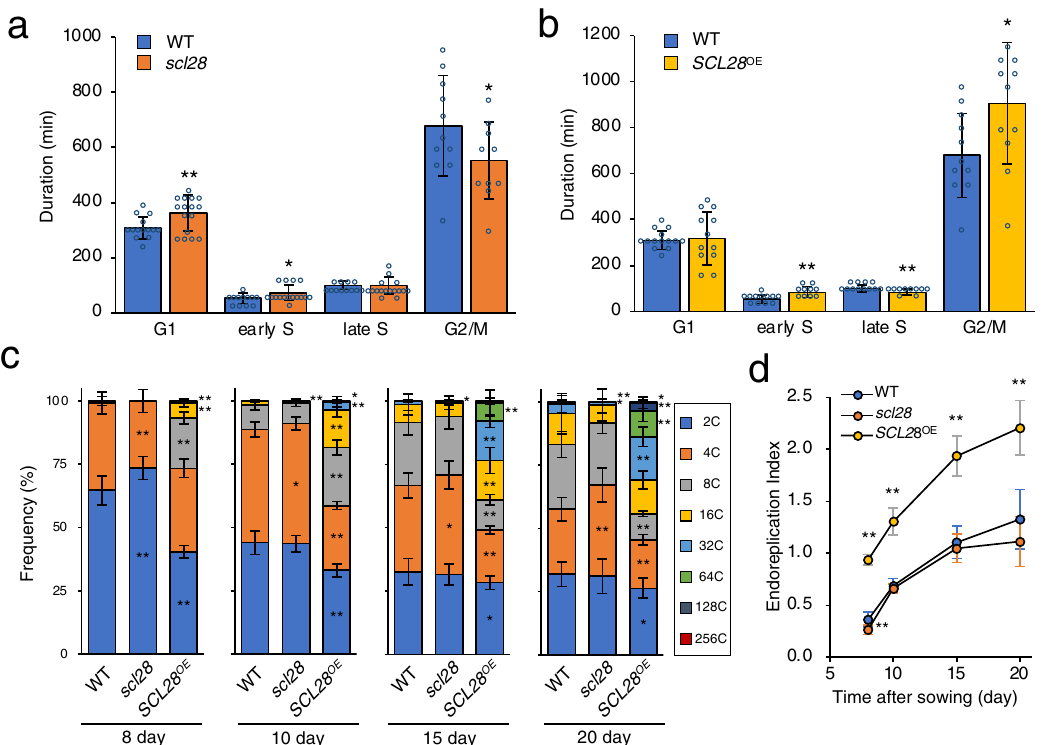
Fig. 3 SCL28 inhibits G2 progression and induces endoreplication. a G2 duration is shortened in scl28 . Epidermal cells in root meristems of WT, scl28 , and SCL28 OE plants carrying the PCNA-GFP marker were analyzed by live-cell imaging for measuring length of G1, early S, late S, and G2/M phases in the cell cycle. Data are shown as averages (±SD). Numbers of biological replicates for calculating length of G1, early S, late S, and G2/M, respectively, are 14, 12, 12 and 11 for WT, and 16, 16, 16 and 10 for scl28 . Statistical signi fi cance compared with WT was determined using one-sided Student ’ s t test. * P < 0.05, ** P < 0.01. b Prolonged G2 duration in SCL28 OE plants. Cell cycle analysis in the root meristem was performed as in ( a ). Data are shown as averages (±SD). Numbers of biological replicates for calculating length of G1, early S, late S, and G2/M, respectively, are 14, 12, 12 and 11 for WT, and 12, 10, 10, and 12 for SCL28 OE . Statistical signi fi cance was determined and shown as in ( a ). c Ploidy analysis of scl28 and SCL28 OE plants. First leaf pairs of WT, scl28 , and SCL28 OE plants were subjected to fl ow cytometric analysis to determine ploidy distribution during leaf development. Data are shown as averages from ten biological replicates (±SD). Statistical signi fi cance compared with WT was determined using two-sided Student ’ s t test. * P < 0.05, ** P < 0.01. d Time- course change in cellular ploidy levels during leaf development. Data presented in ( c ) were used for calculating endoreplication index, which represents mean number of endoreplication cycles per leaf cells. Data are shown as averages from ten biological replicates (±SD). Statistical signi fi cance compared with WT was determined and shown as in ( c